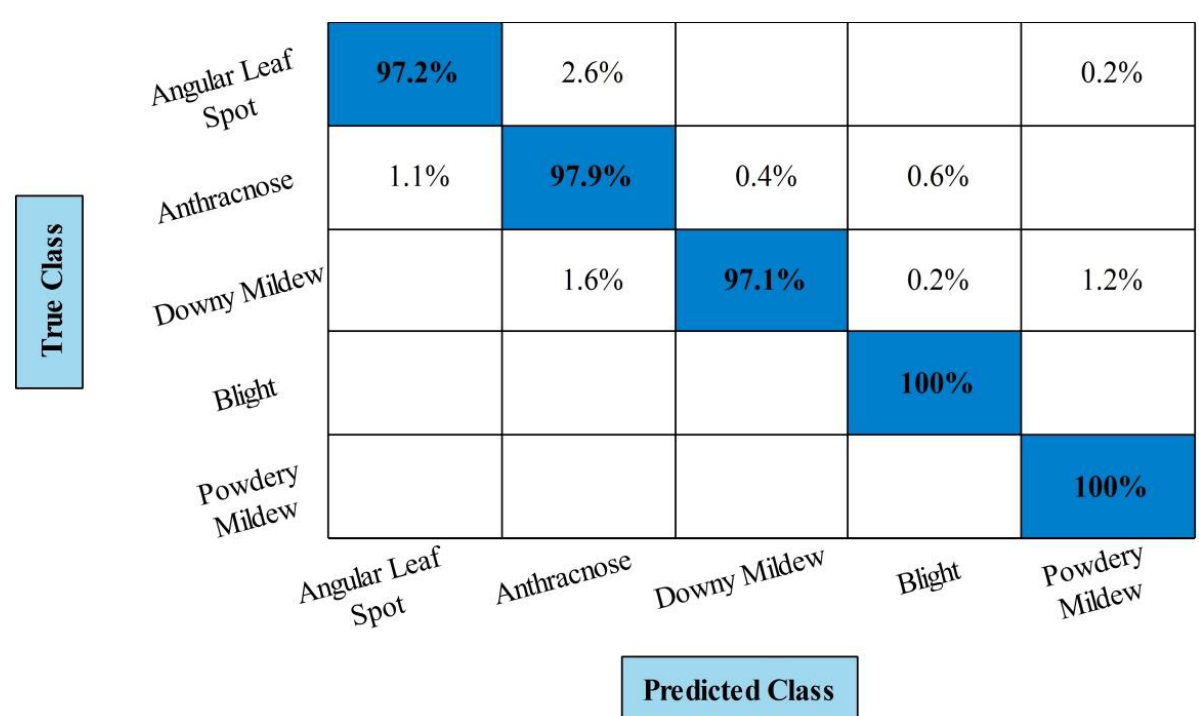
Figure 4. Confusion matrix-based representation of Cubic SVM accuracy.